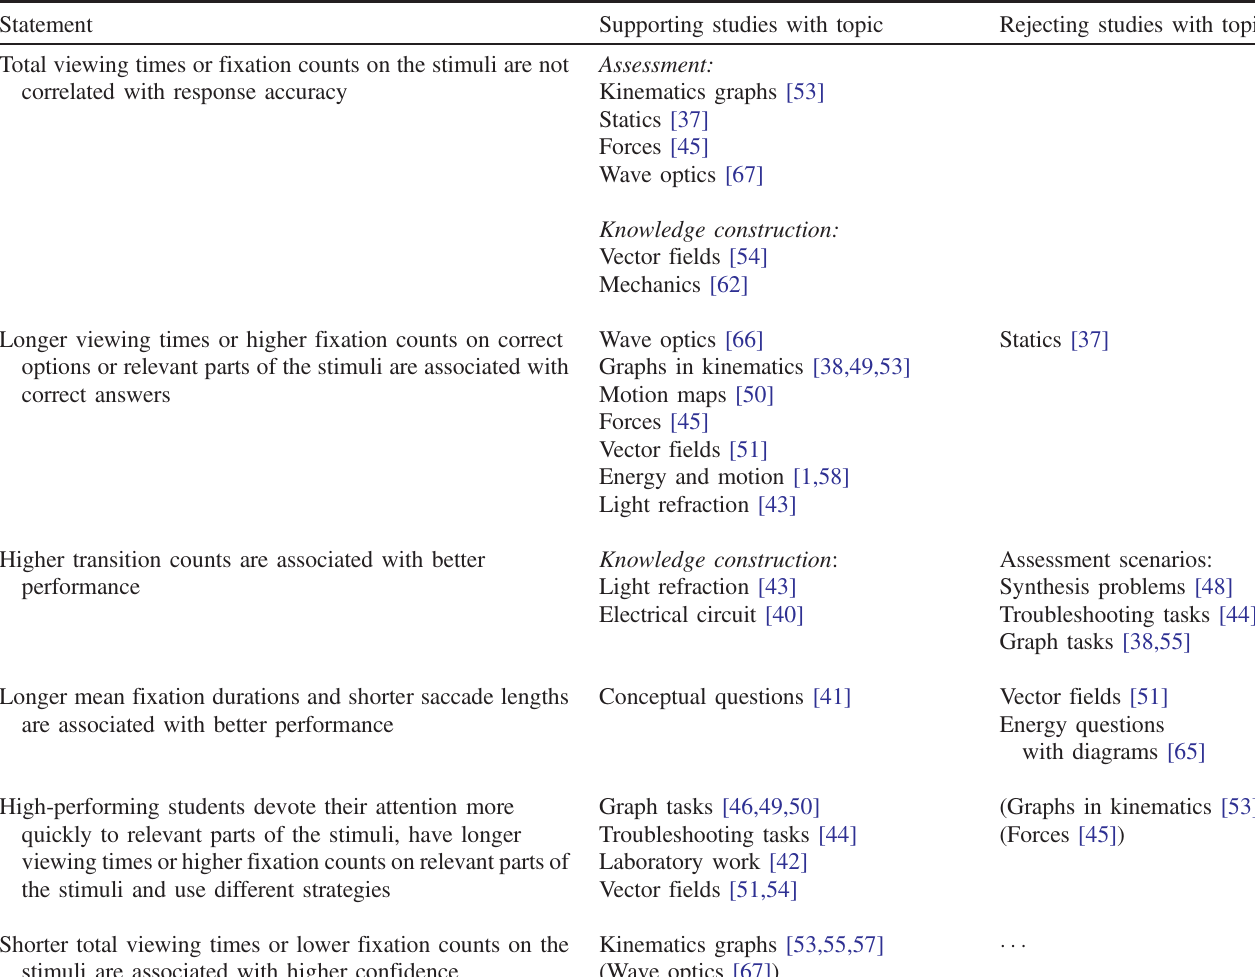
TABLE V. Overview of performance-related results from the eye-tracking studies. The results are phrased as statements, and studies that do or do not support the statements are listed.